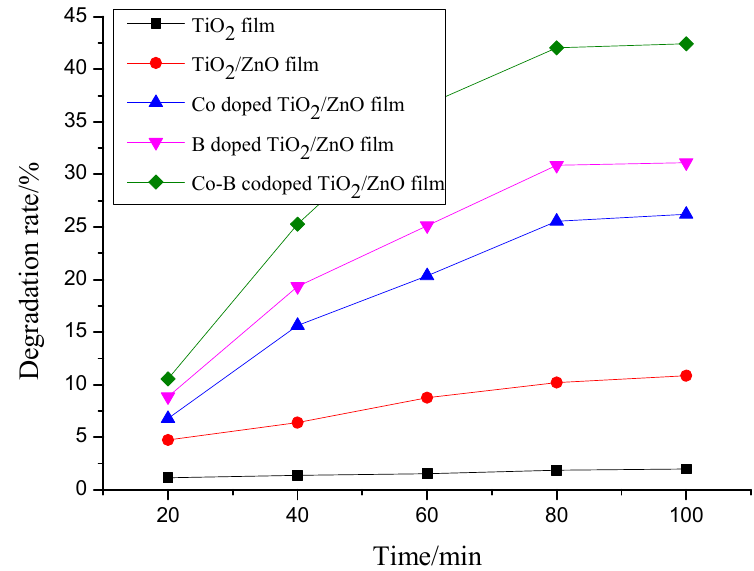
Figure 3. Decomposition kinetics of oxytetracycline solutions using pure TiO 2 , composite TiO 2 /ZnO, Co doped TiO 2 /ZnO, B doped TiO 2 /ZnO, and Co-B codoped TiO 2 /ZnO films on glass substrates under visible light irradiation for 100 min.